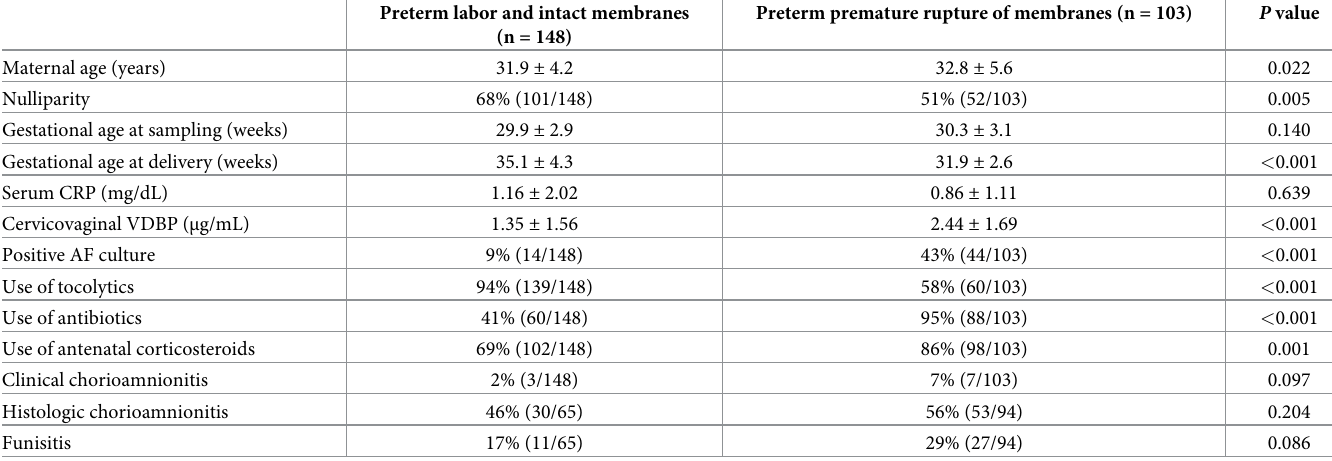
Table 5. Clinical characteristics of the study population according to the status of the fetal membrane (intact or ruptured membranes). Preterm labor and intact membranes (n =